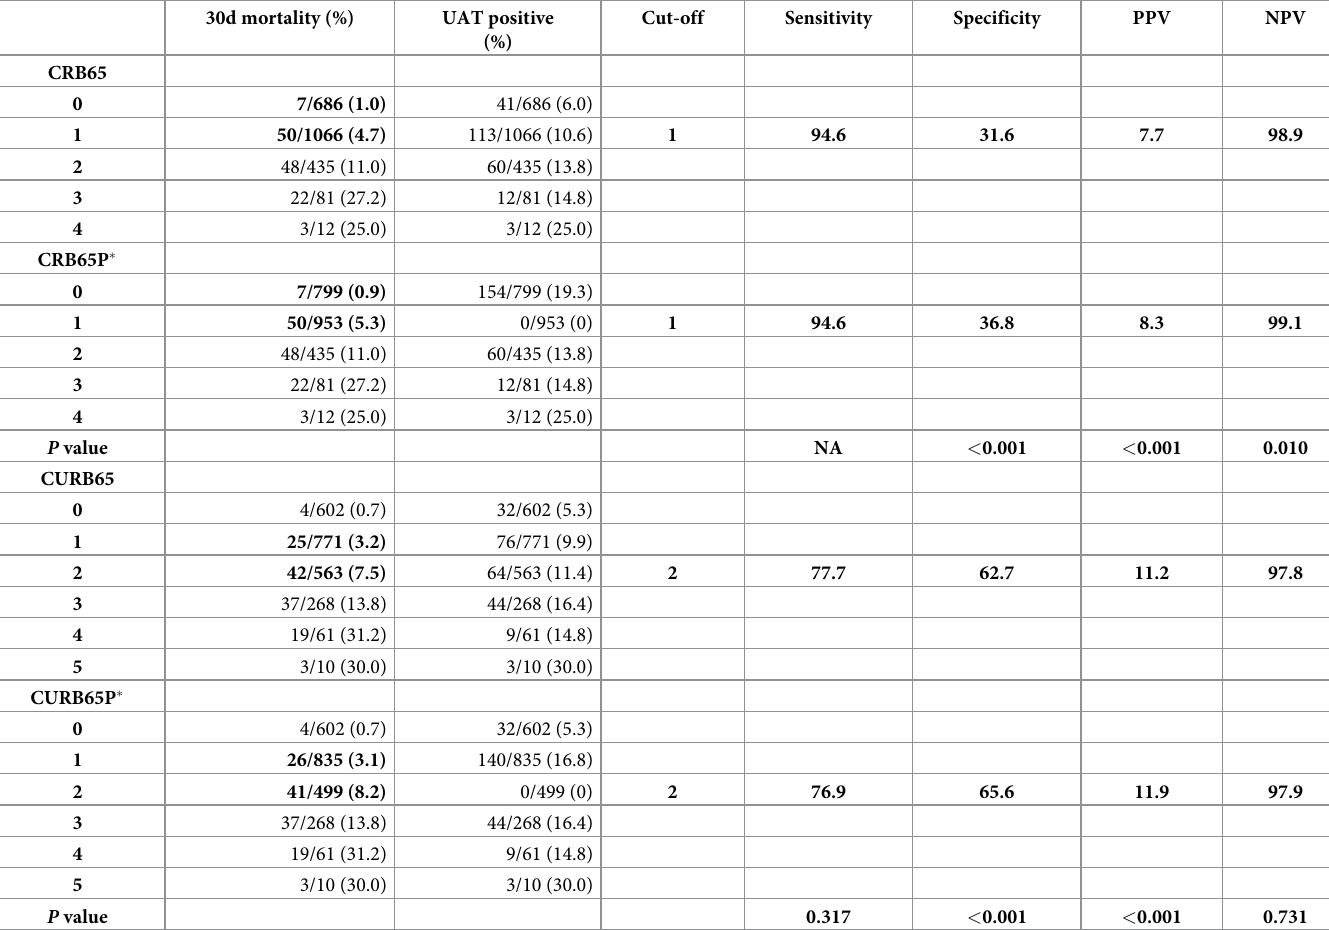
Table 4. Sensitivity, specificity, PPV and NPV changes from modification of scoring